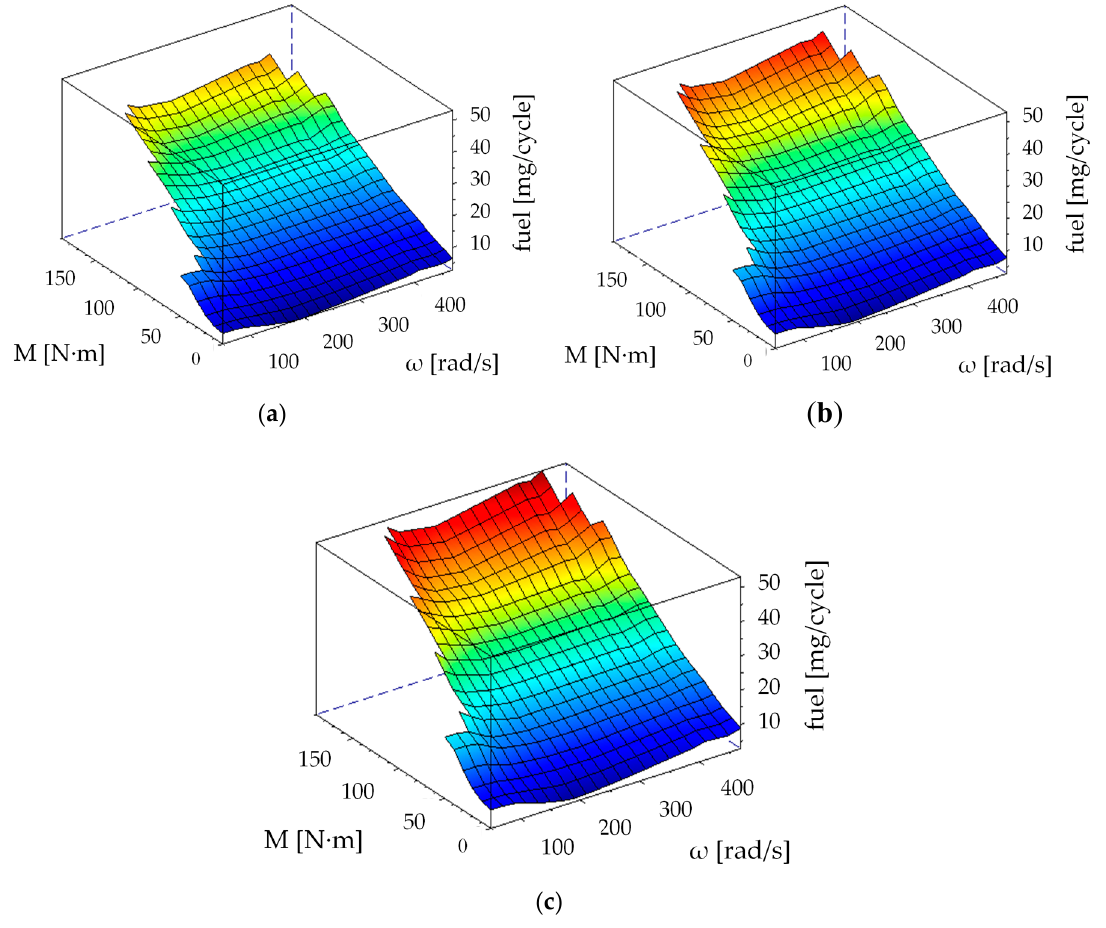
Figure 4. Fuel flow per injection cycle: ( a )—Diesel; ( b )—FAME; ( c )—Butanol. Energies 2020 , 13 , 561